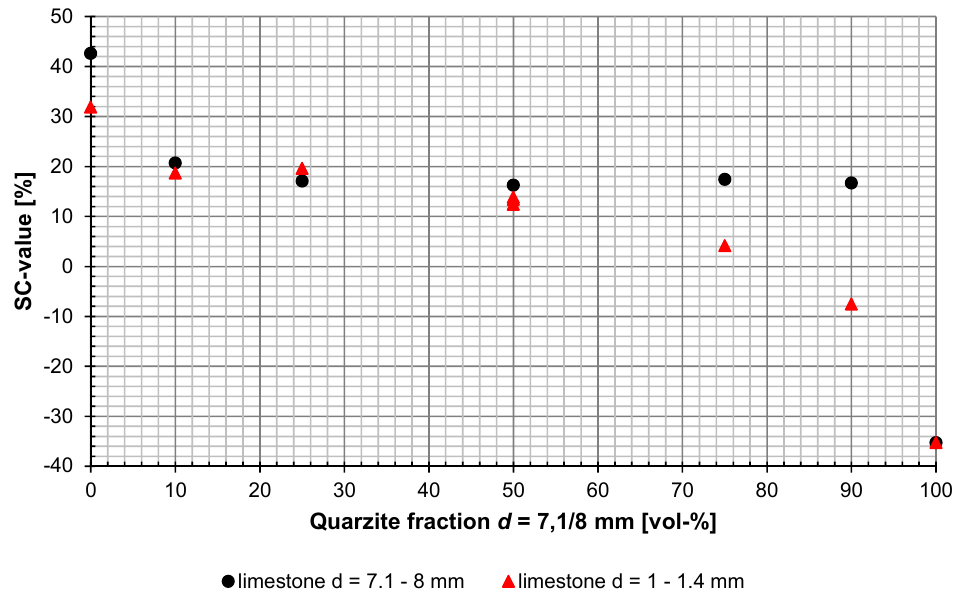
Figure 5. Selective comminution for mixtures of narrow fractions of quartzite and limestone.